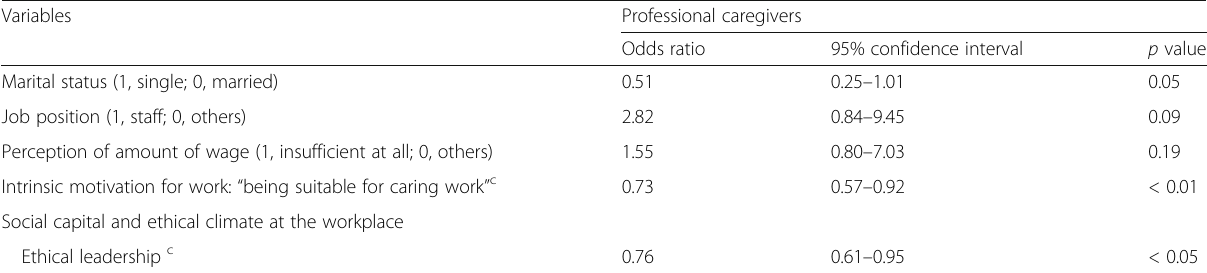
Table 4 Multivariable logistic regression model for intention to quit current organization by the end of the year ( n = 667) a,b Variables Professional